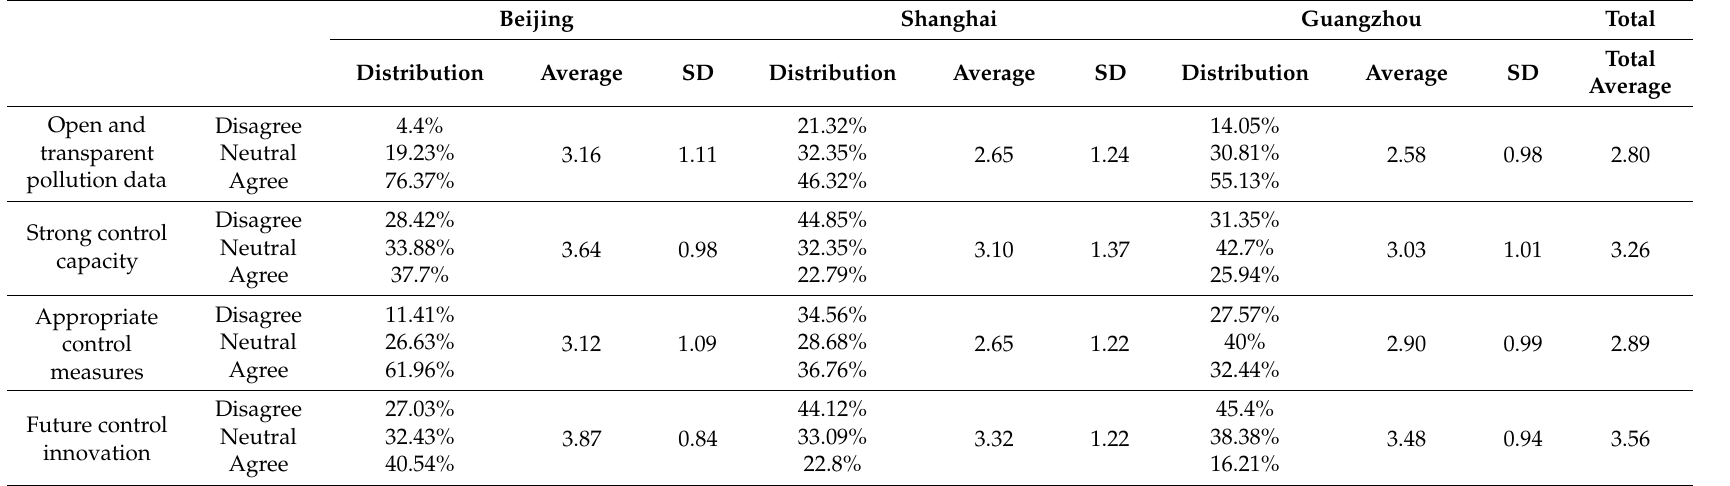
Table 5. Distribution of political trust in Beijing, Shanghai, and Guangzhou.